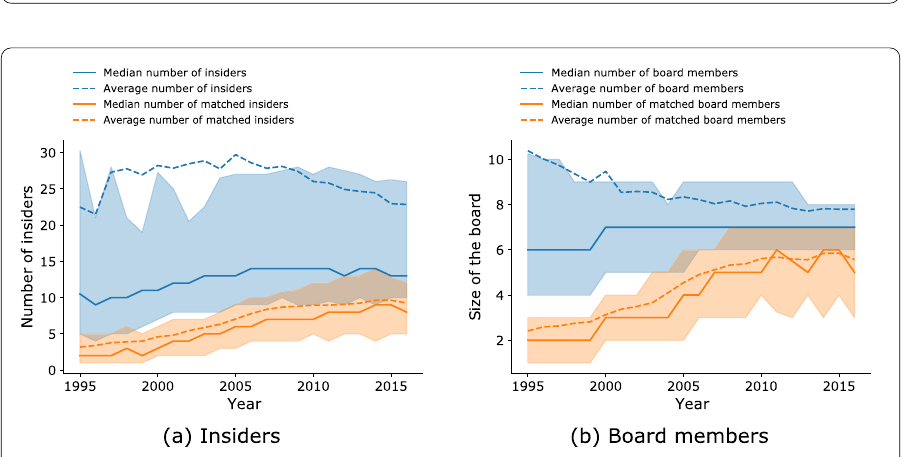
Figure 10 Number of insiders and board members. ( a ) Median and average number of insiders and matched insiders per company in a year. ( b ) Median and average number of board members and matched board members per company in a year. The bands around the medians are filled between 1st and 3rd quantiles